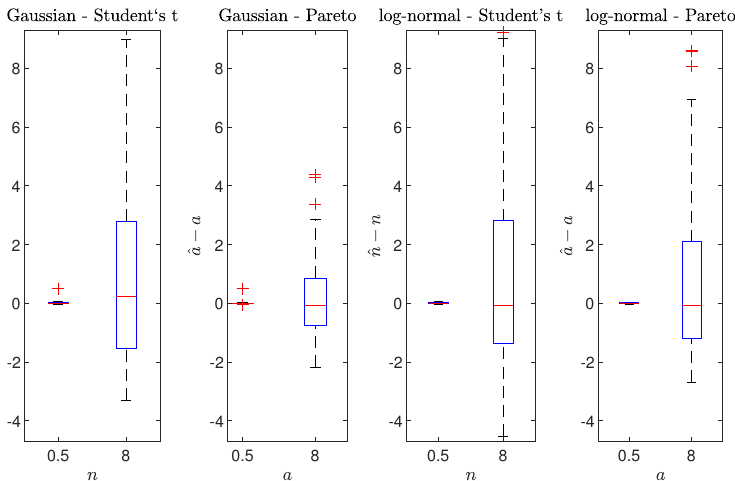
Figure 12. Boxplots of the errors of the degrees of freedom ˆ n and the tail parameter ˆ a estimators for the products of the Gaussian or log-normal distribution and Student’s t or Pareto distribution, respectively. The parameters of the Gaussian and log-normal distribution were set to µ X = 0 and σ X = 1. The Student’s t distribution was simulated with n = 0.5 or n = 8 degrees of freedom, while the Pareto distribution with θ = 1 and a = 0.5 or a = 8. The length of each sample was equal to 1000, while the number of repetitions was equal to